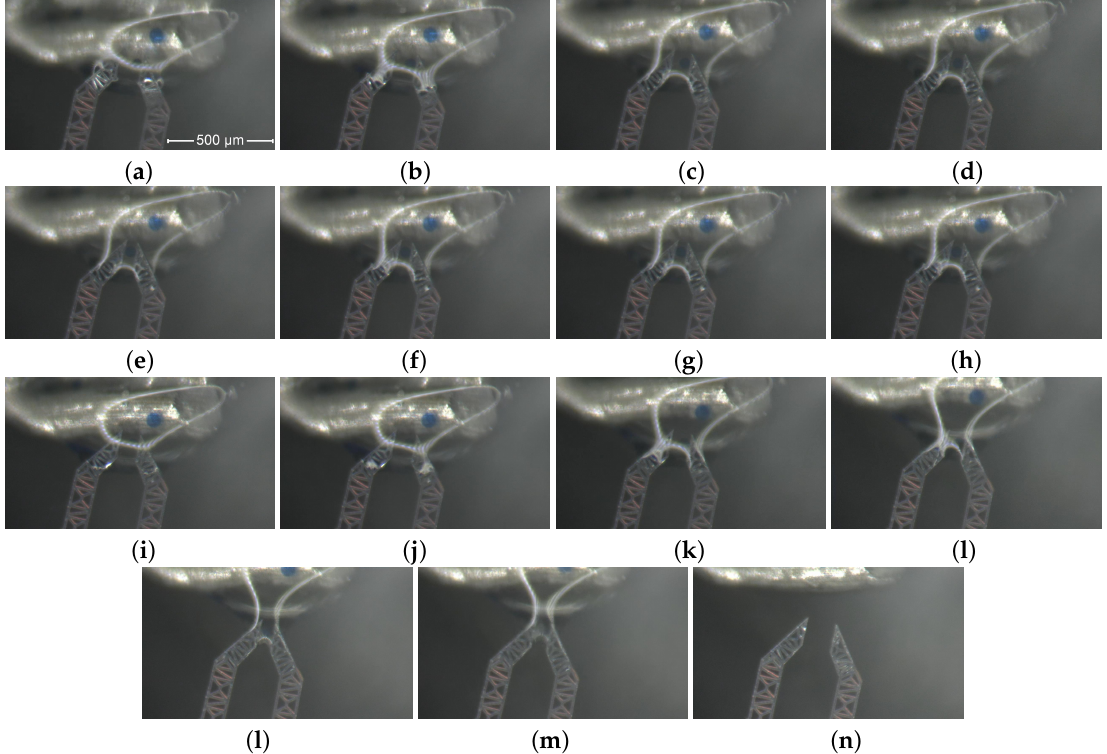
Figure 9. A sequence that illustrates the gripper jaws grasping a bead inside the water drop: progressive approaching to the agarose bead, from ( a ) to ( c ); contact with the bead( d ) ; grasping, from ( e ) to ( h ); releasing ( i ); exit from the drop, from ( j ) to ( n